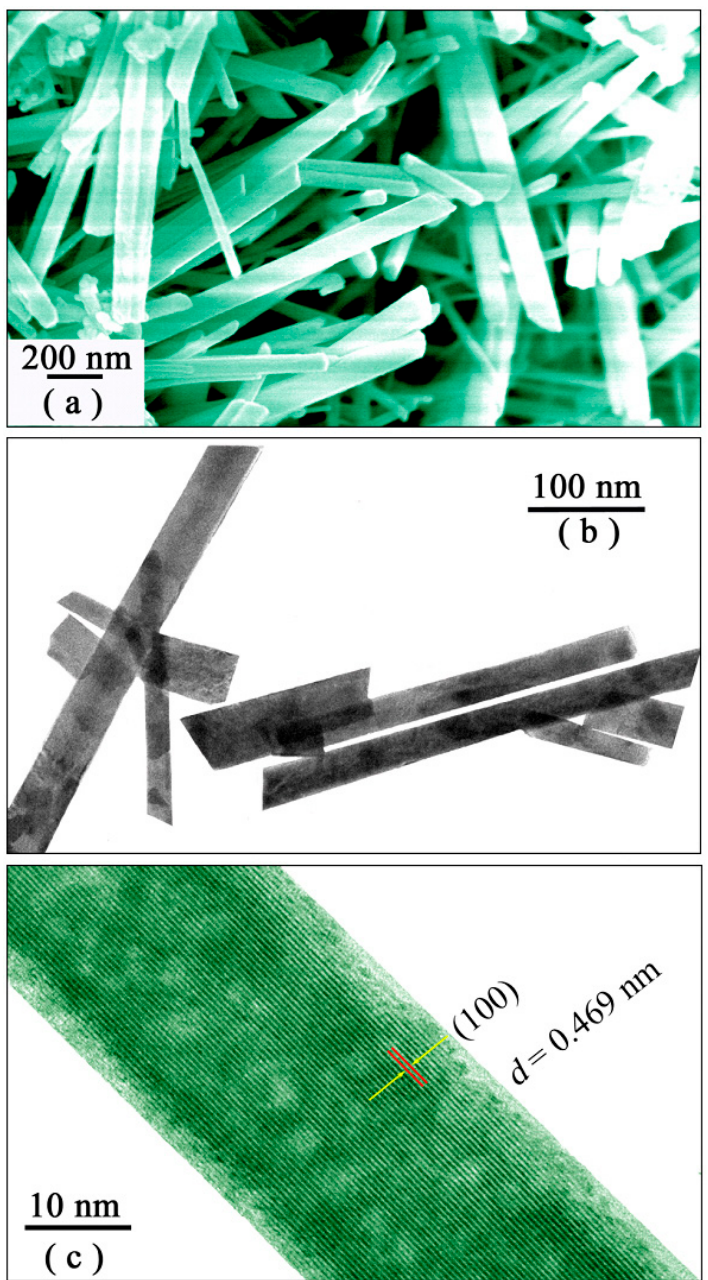
Figure 1. SEM micrograph ( a ), low-resolution TEM micrograph ( b ), and high-resolution TEM micrograph ( c ) of ZnWO 4 nanoplates.